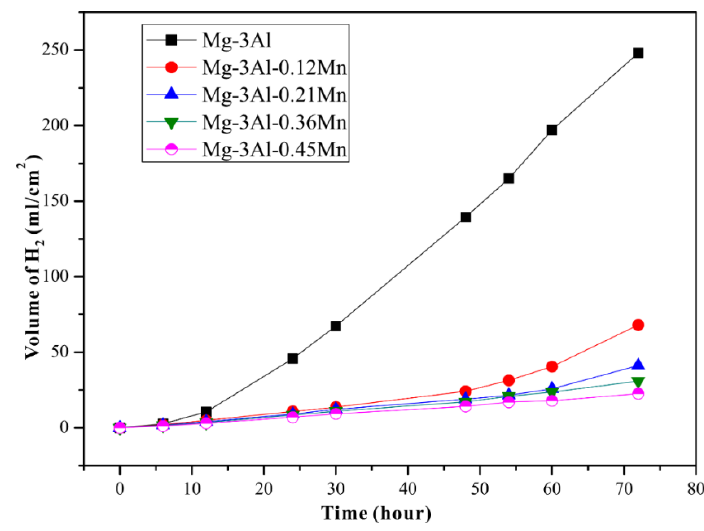
Figure 14. Hydrogen evolution curves of the Mg-3Al- x Mn samples immersed in 3.5 wt.% NaCl solution at room temperature.